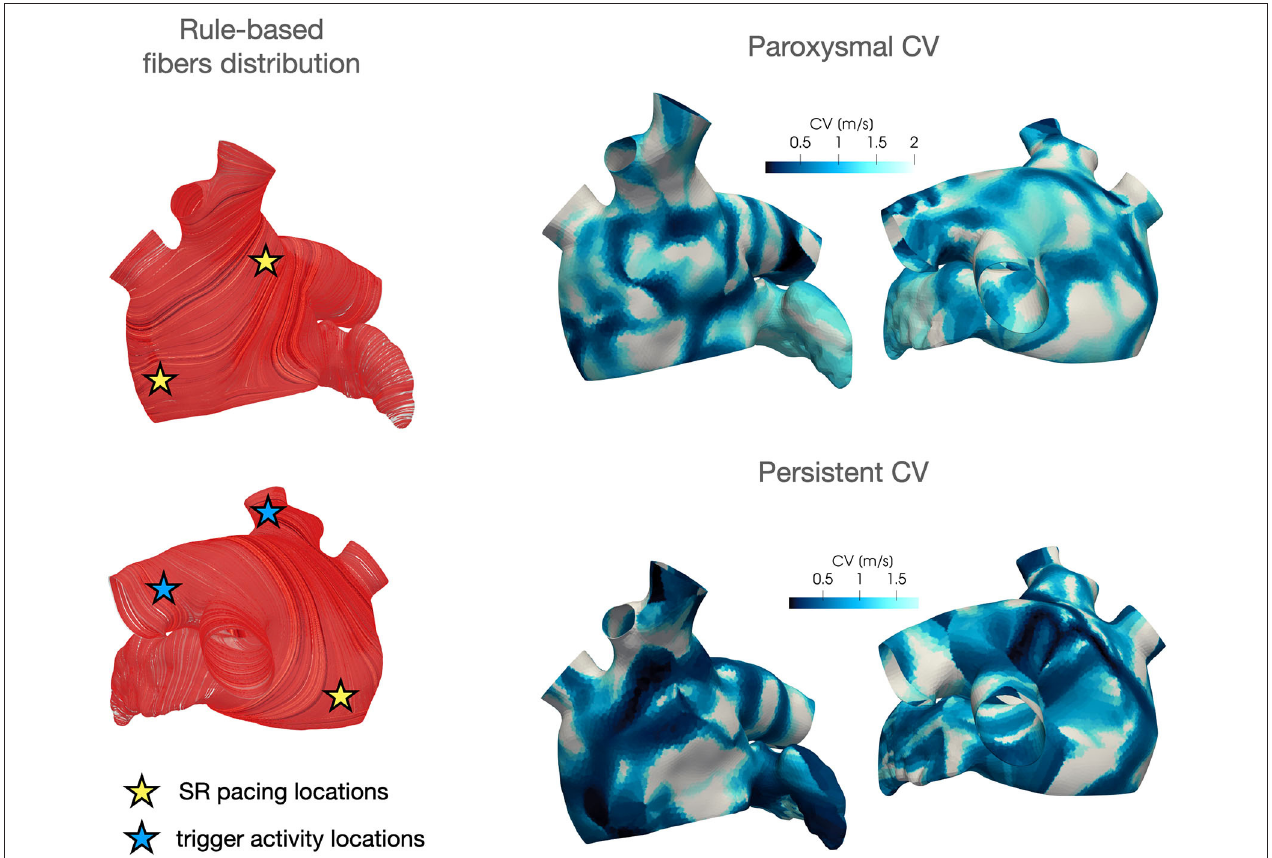
FIGURE 5 | LDRBM fibers distribution and projected CV field for the two patients considered in this work.